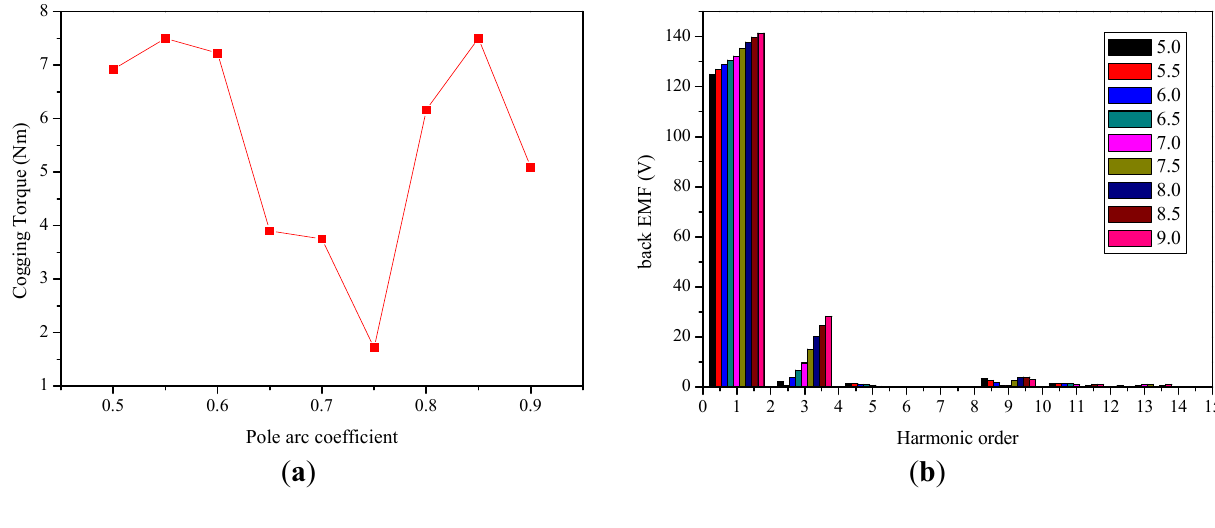
Figure 14. Performance varies with different pole arc coefficient: ( a ) cogging torque; and ( b ) spectrum for the back EMFs in all